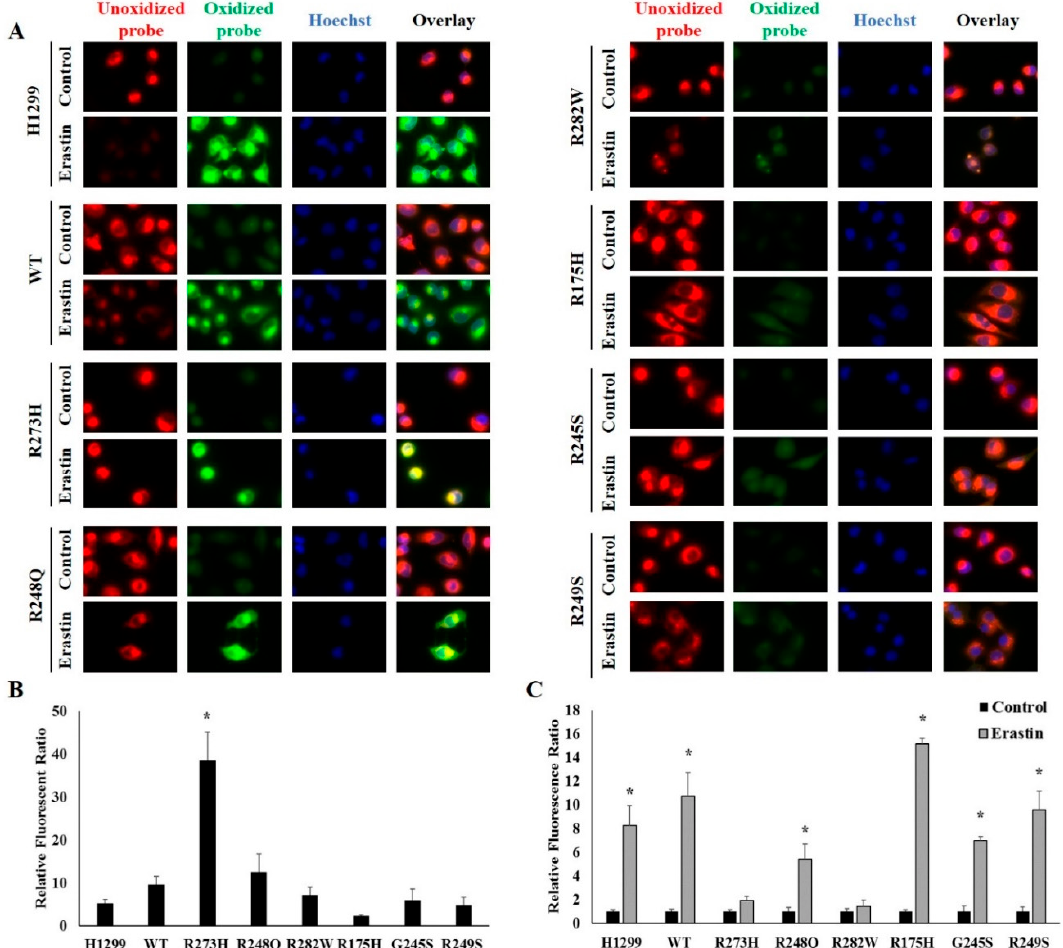
Figure 5. Mutant TP53 expression influences basal and erastin-induced levels of lipid peroxidation. ( A ) Unoxidized and oxidized C11-BODIPY in tetracycline-induced WT and mutant TP53-expressing following treatment with DMSO (control) or 10 µM erastin (Erastin) for 24 ( n = 3–4 per cell type and treatment). ( B , C ) Changes in relative amounts of oxidized probe were quantified using ImageJ software following normalization to Hoechst nuclear staining to account for di ff erences in cell number. ( B ) Student’s t -tests were used to identify statistically significant erastin responses relative to their controls within a given cell type. Relative fluorescence ratios for erastin-treated cells are shown normalized to the relative fluorescence ratios of their respective controls. * Denotes significant di ff erence from control. ( C ) A one-way between-subjects ANOVA identified a significant e ff ect of TP53 mutation type on basal oxidized probe at the p < 0.05 level for the 8 cell types (F (7,16) = 13.563, p < 0.001). * Post hoc comparisons using the Tukey LSD test indicated that basal levels of lipid peroxidation in the R273H-expressing mutants was significantly di ff erent from the WT TP53-expressing cells ( p < 0.001). All images were acquired using a 100X objective under immersion oil. Error bars indicate